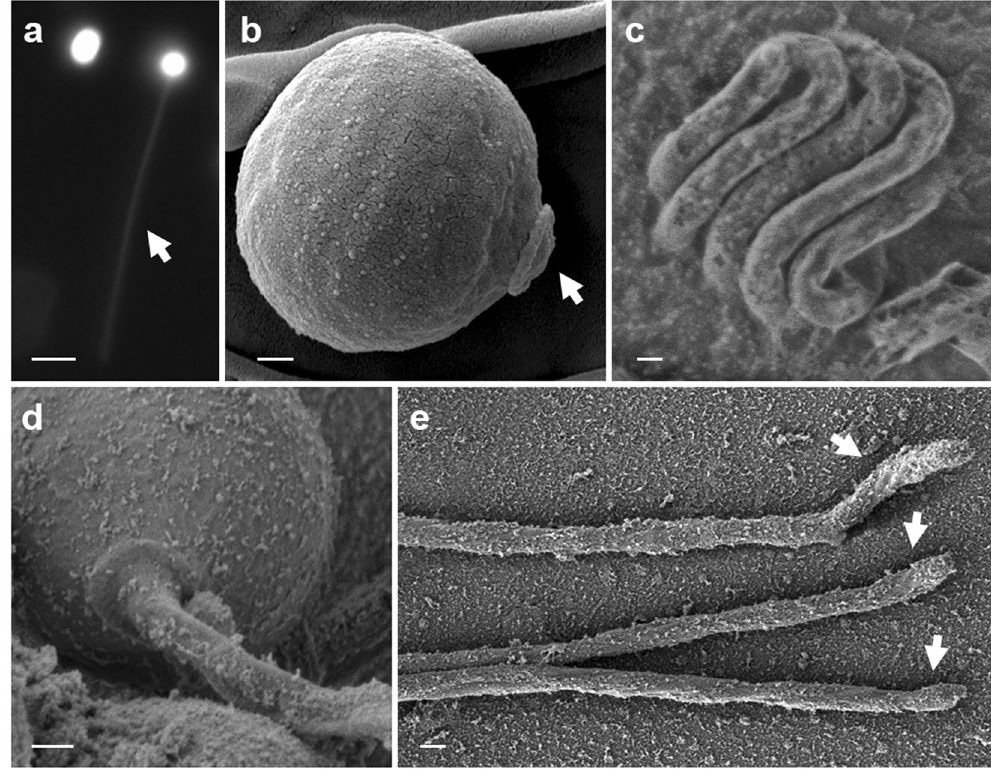
Figure 4. Light microscope and SEM images of polar capsules and tubules. ( a ) Intact and activated polar capsules, pre-stained with Acridine orange. The arrow marks the florescence-stained tubule of the activated polar capsule; note that the activated capsules retain the dye. Bar = 5 μ m. ( b ) SEM image of an unfired capsule. The operculum (arrow) is distinct. ( c ) Cryo-SEM image of the inverted, highly-packed tubule folded within an intact capsule. ( d ) Activated capsule with the everted tubule. ( e ) Released tubules with hooked ends (arrowed). Scale bars ( b–e ) 200